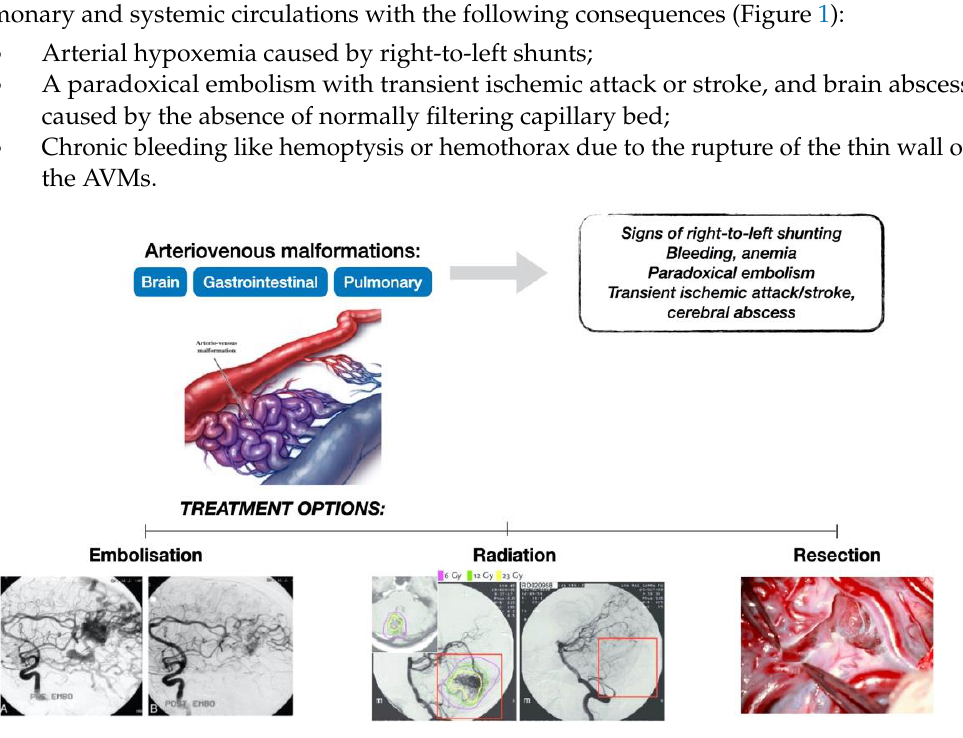
Figure 1. Arterio-venous malformations: from clinical consequences to treatment modalities.